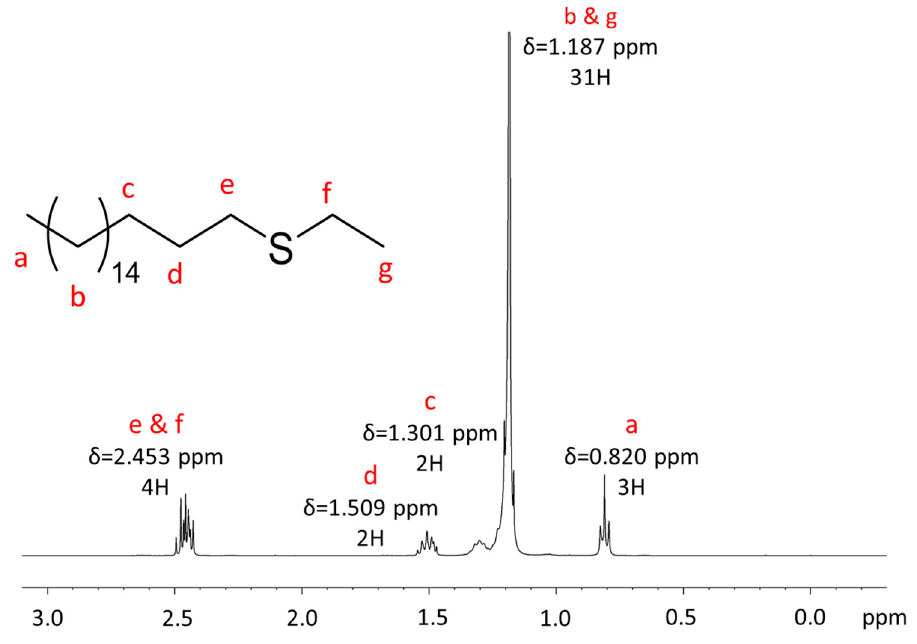
Figure A3. 1 H NMR of ethylsulfanyloctadecane.